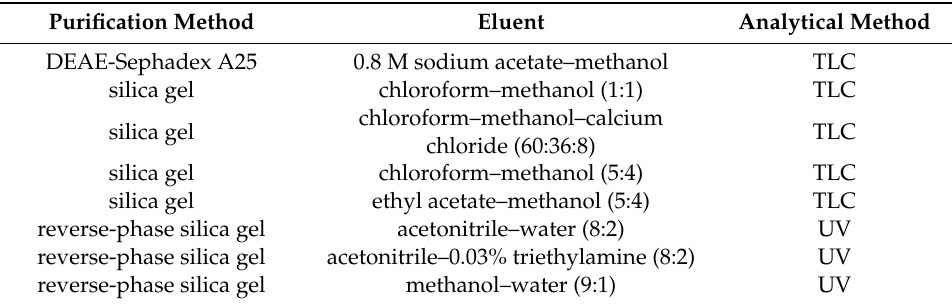
Table 3. Optimization of purification method of